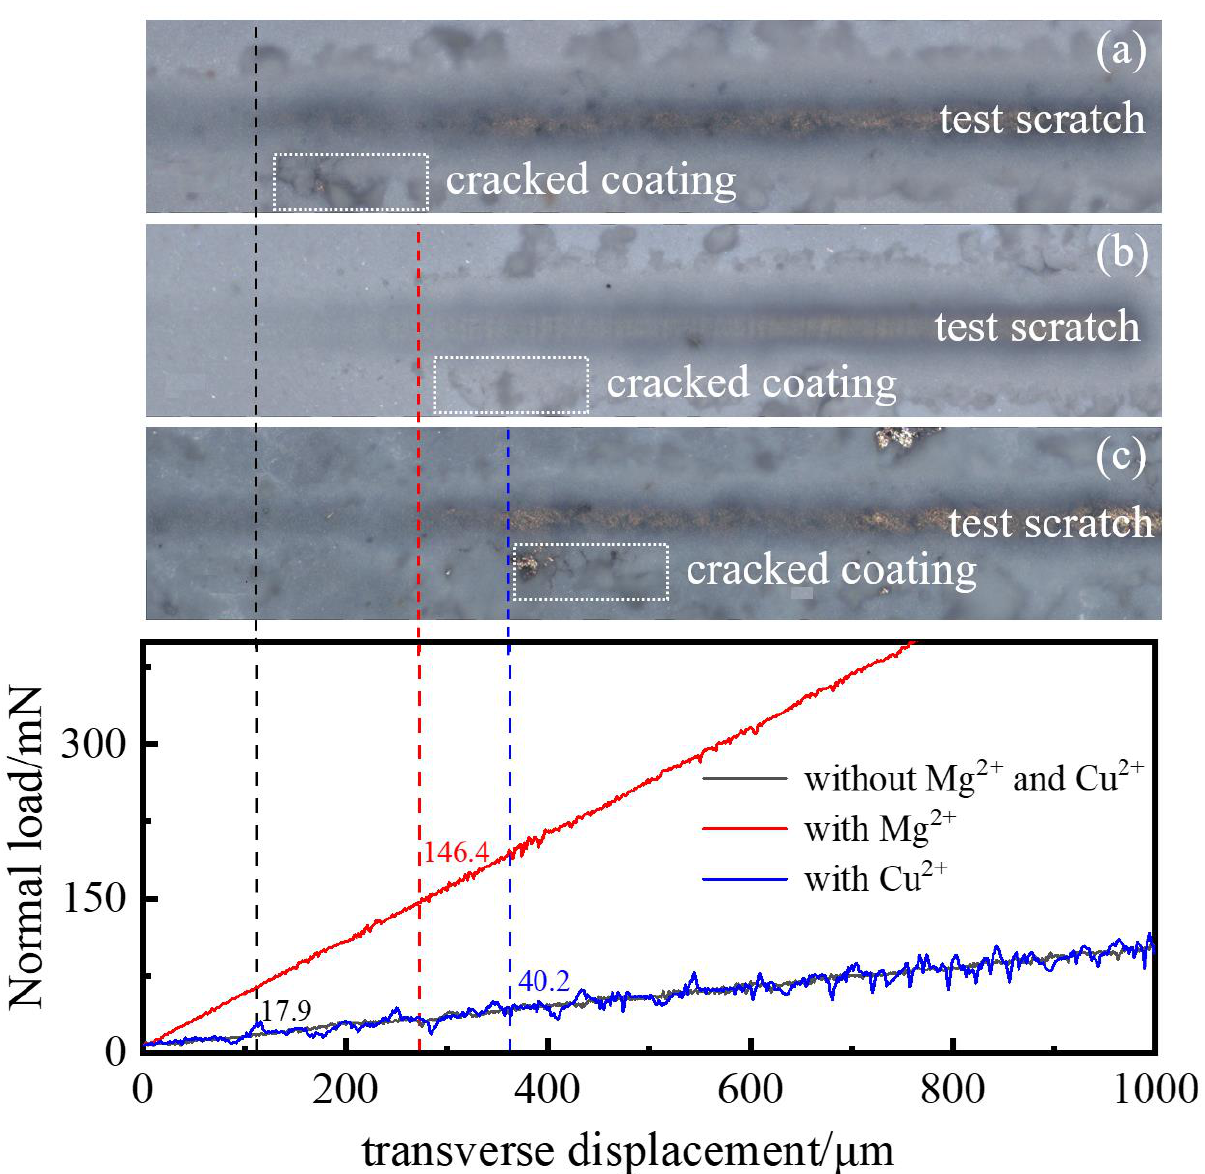
Figure 8. Scratch test results of EPD coating. ( a ) Without Mg 2+ and Cu 2+ ; ( b ) with Mg 2+ ; ( c ) with Cu 2+ .